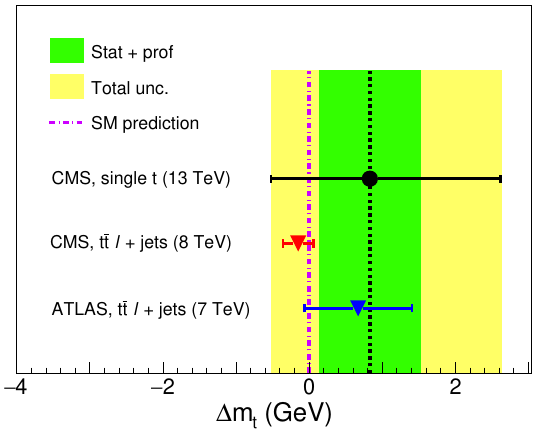
measurement from this analysis (black circle) with the Figure 10 . A comparison of the ∆ m t previous ATLAS [91] and CMS [92] results in tt events at 7 and 8 TeV, respectively. The horizontal bars on the points show the combined statistical and systematic uncertainties in each measurement. The vertical dashed black line indicates the central value obtained from this measurement, and the vertical dash-dotted magenta line is the SM prediction. The green band represents the combined statistical and profiled systematic uncertainties in the present result, whereas the yellow band shows the total